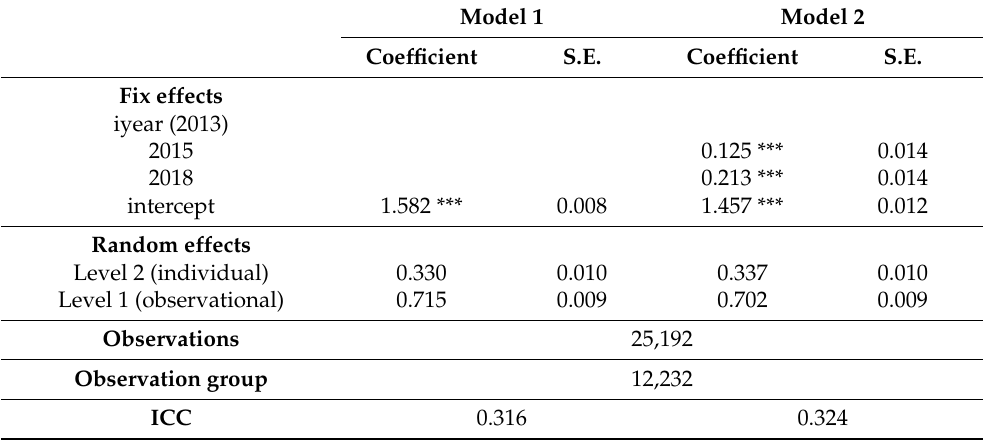
Table 2. Hierarchical linear model of